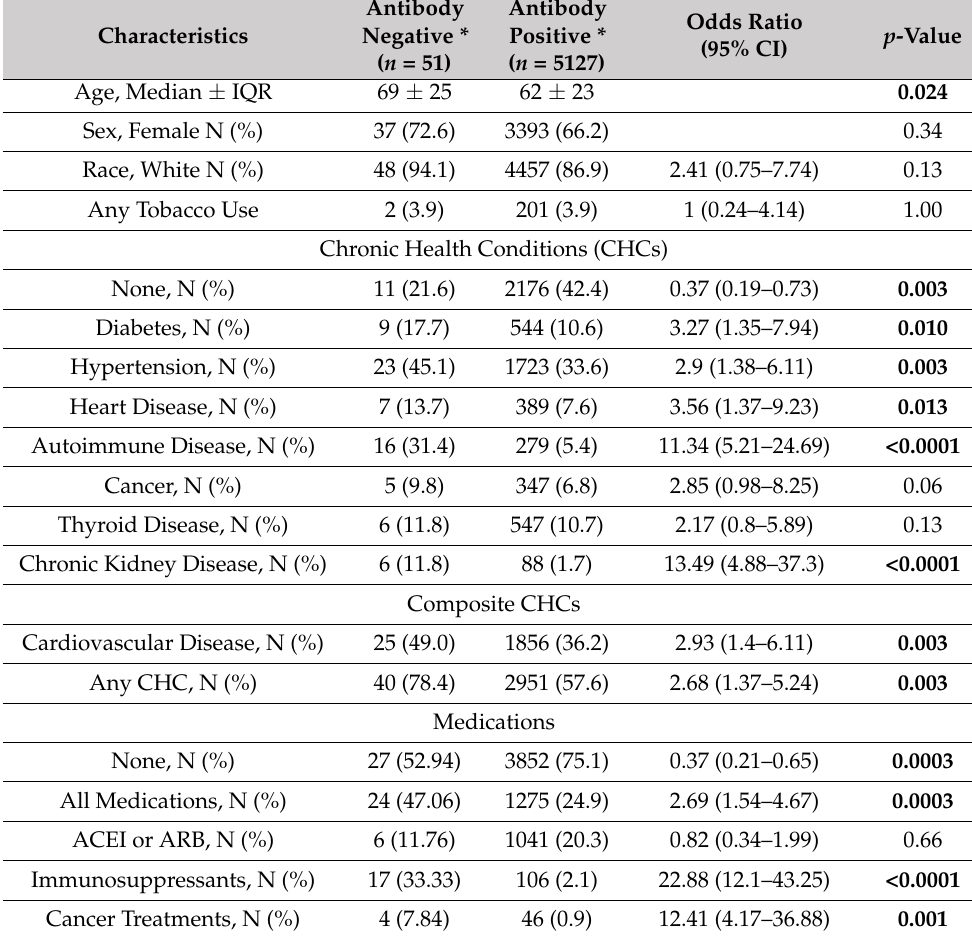
Table 1. Univariate comparison of clinical characteristics between study